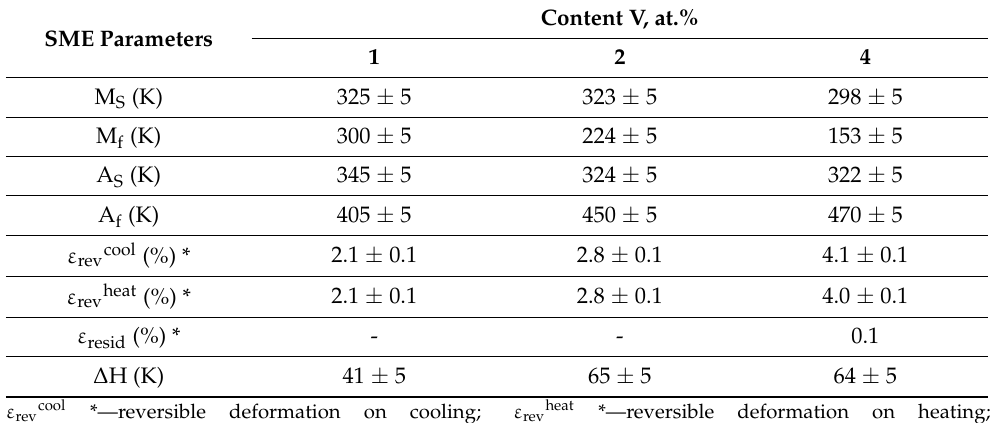
Table 4. Characteristics of multiple SME in TiNi alloys doped with V. SME Parameters